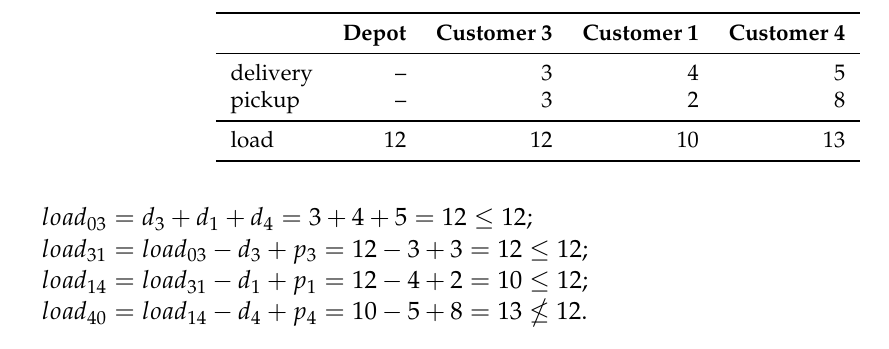
Table 3. Vehicle load of the tentative route 0 − 3 − 1 − 4 − 0.